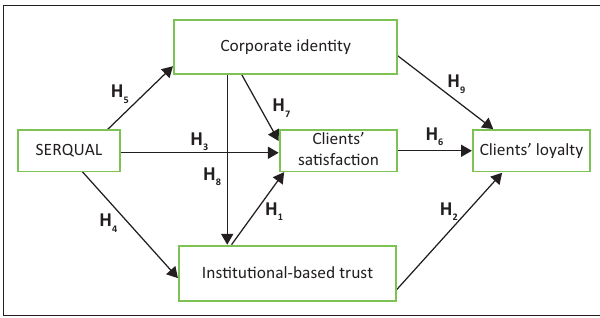
FIGURE 1: Proposed research model.